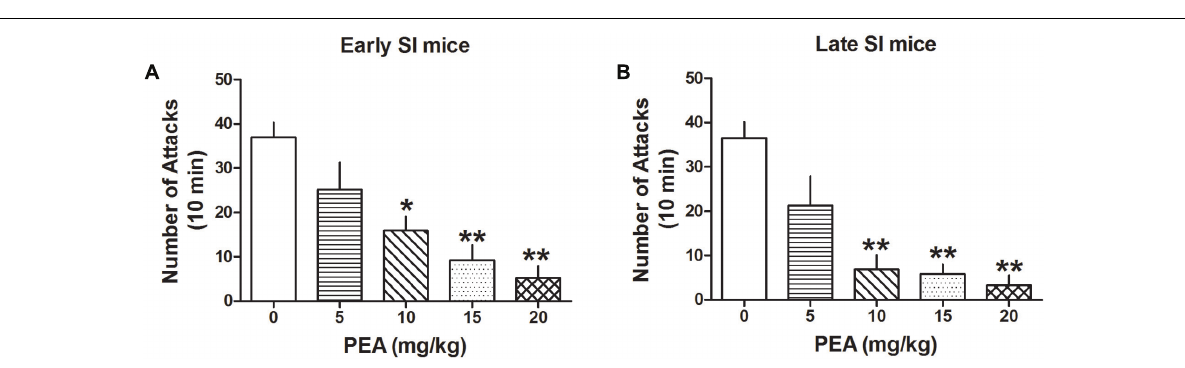
FIGURE 5 | The endocannabinoid PEA strongly decreases aggressive behavior in early and late SI mice. PEA at the doses of 5, 10, 15, and 20 mg/kg was administered both to early (A) and late (B) SI mice 60 min before the exposure to a resident–intruder test. The EC 50 values were 8 and 6.5 mg/kg, respectively. Data represent the mean ± SEM of 7–17 mice. ∗ p < 0.01; ∗∗ p < 0.001, when compared with basal control levels of